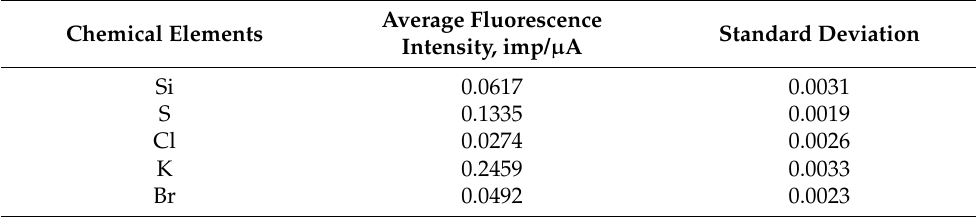
Table 2. Elemental composition of Aloe vera extract and AgNP phytoproduct.